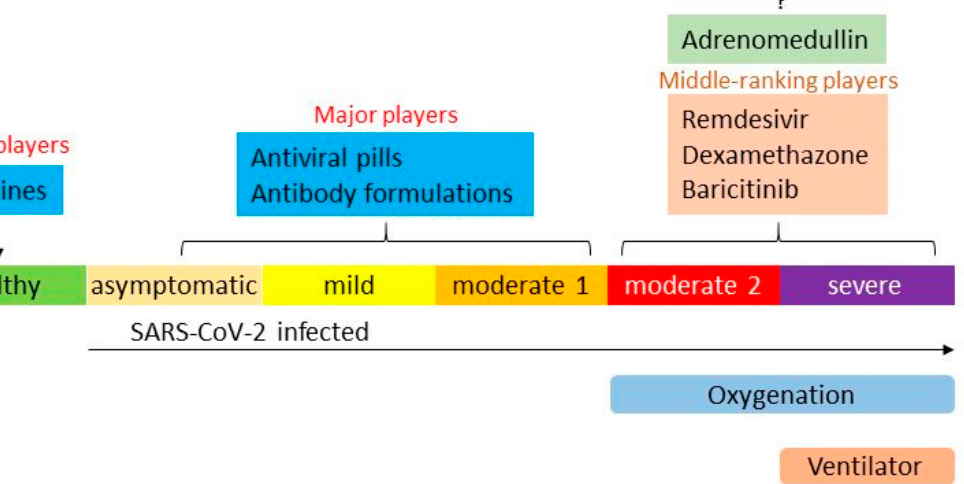
Figure 1. Current COVID-19 therapeutics, including adrenomedullin, under investigation in clinical trials .